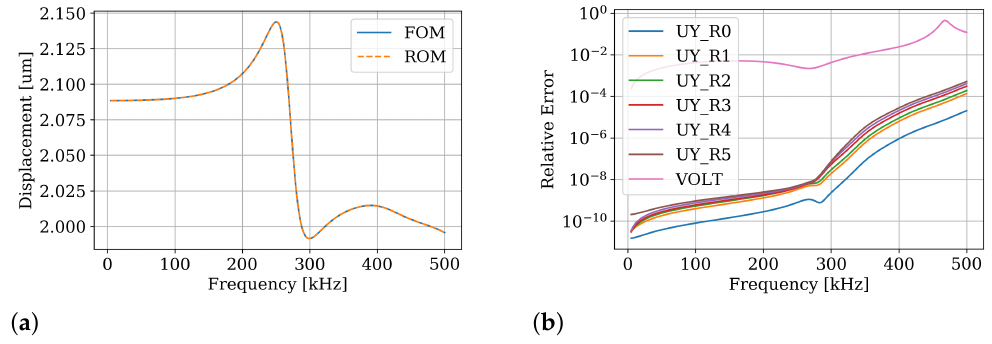
Figure 7. ( a ) Comparison of the center node’s harmonic displacement amplitude obtained by the original FEM model and the ROM in a frequency range of 0kHz to 500kHz. ( b ) The harmonic relative error of the ROM’s solution for all seven outputs, demonstrating its accuracy. The ROM approximates the original transfer function at an expansion point of 0Hz. Consequently, all errors are the lowest at this frequency and increase with higher frequencies. Extending the reduced basis with vectors for higher frequencies enhances accuracy if needed. The error plots for the remaining six inputs are provided by Appendix